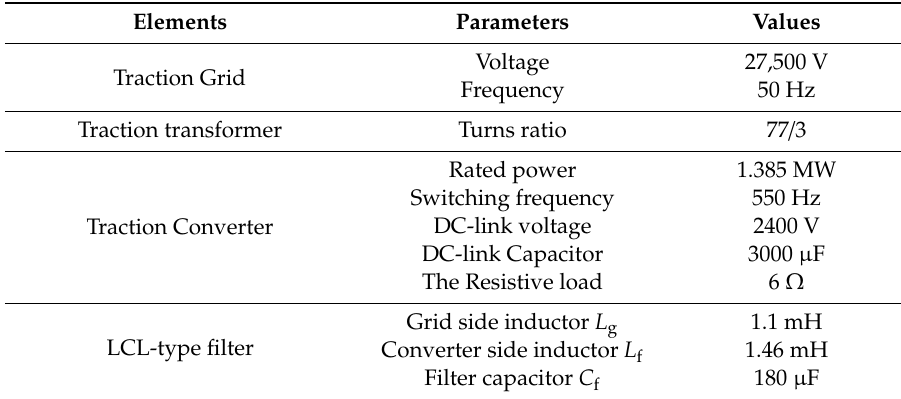
Table 1. Parameters of the HSTT with IFIs and traction drive system for simulation.